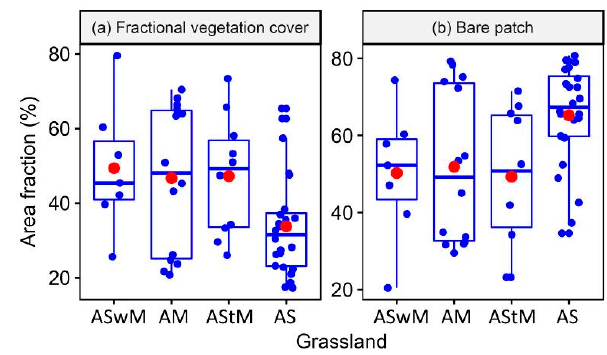
Figure 8. Fractional vegetation cover ( a ) and bare patch area fraction ( b ) of four typical alpine grasslands. Red dots mean the average value. Blue dots are the value of all sampling sites (n = 55). The blue bold solid horizontal lines are the median value. ASwM, AM, AStM and AS indicate alpine swamp meadow, alpine meadow, alpine steppe meadow and alpine steppe, respectively. Table 3. One-way ANOVA of vegetation biomass of functional groups among the four types of alpine grasslands. λ 2 and F are the results of multiple comparison of the Kruskal–Wallis H model and Tukey HSD model. Significant di ff erences are indicated by p values. *, p < 0.05; **, p < 0.01; ns, no significant di ff erence.